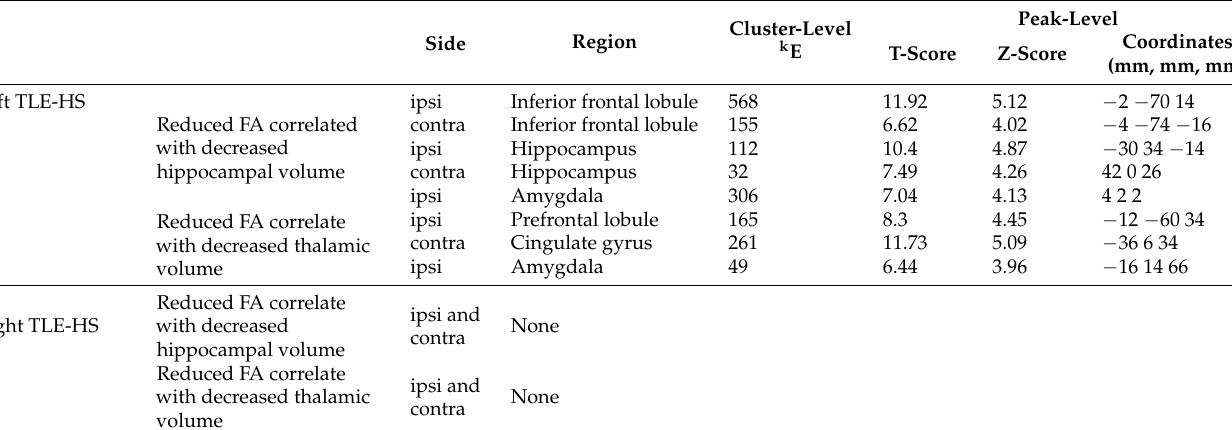
Table 3. Brain regions exhibiting diffusion abnormalities in the left or right TLE with